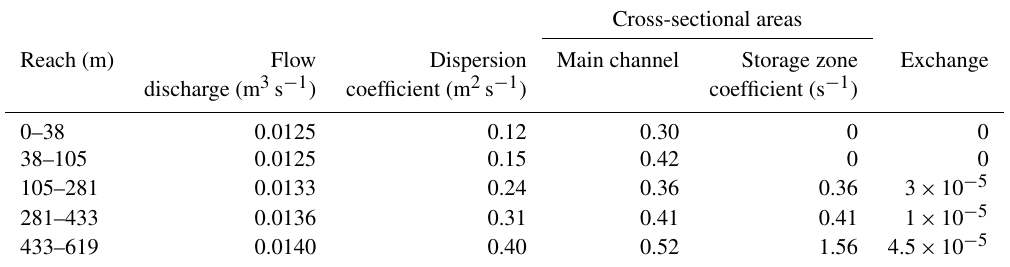
Table 10. Simulation parameters for the Uvas Creek experiment (test case 3).